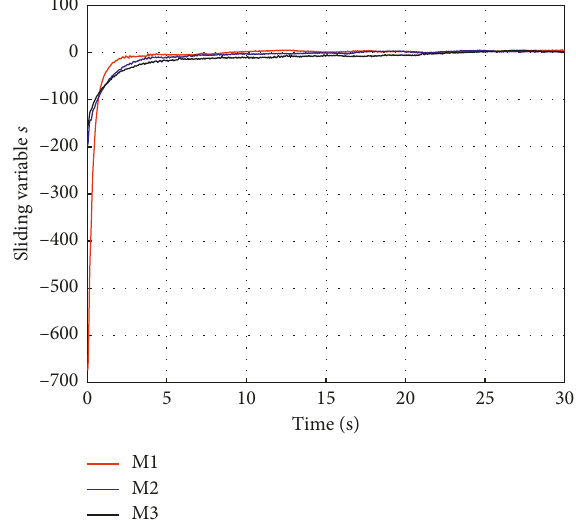
Figure 5: Time response of the angular velocity x value ( i ) .